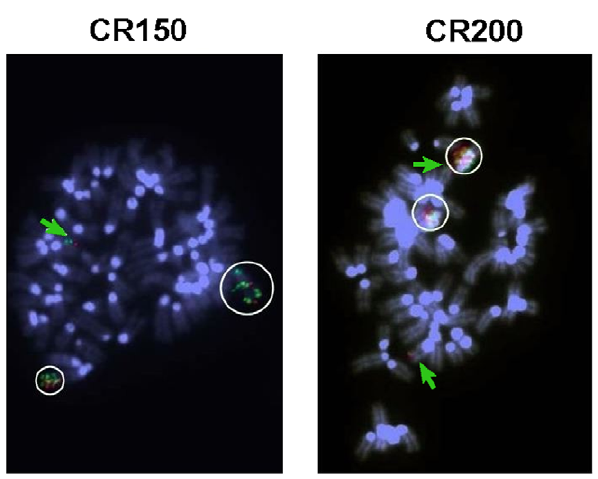
Figure 4. DnajC3 and Abcc4 FISH analysis in selected resistant cell lines. Metaphase spreads of CR150 (left) and CR200 (clone II; right) cells were subjected to FISH analysis with an Abcc4 BAC probe (green) and a DnajC3 BAC probe (red). Chromosomes were counterstained with DAPI. Colocalization of both probes in amplified regions is highlighted with white circles; green arrow indicates Chr 14 with Abcc4 and DnajC3 copies.